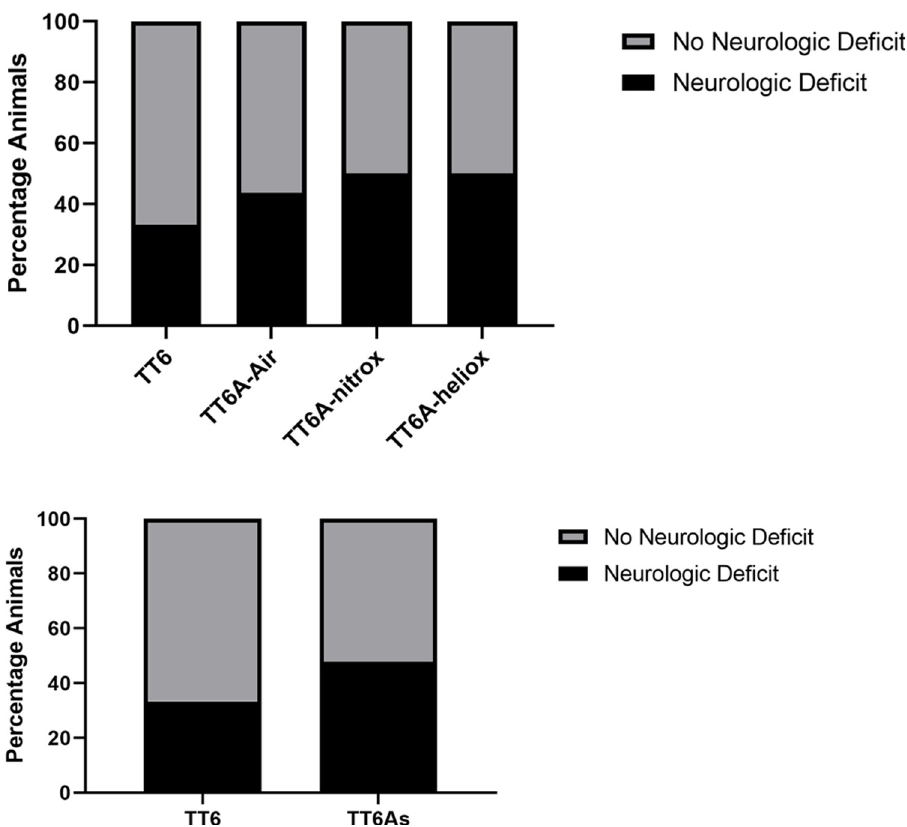
Fig 5. Bar graph showing the gross neurologic outcomes for animals in each treatment group (A, chi-square test, p = 0.77) and each treatment profile (B, chi-square test, p = 0.33, OR 1.83, 95% CI: 0.54–6.21) 24 hours post-insult and